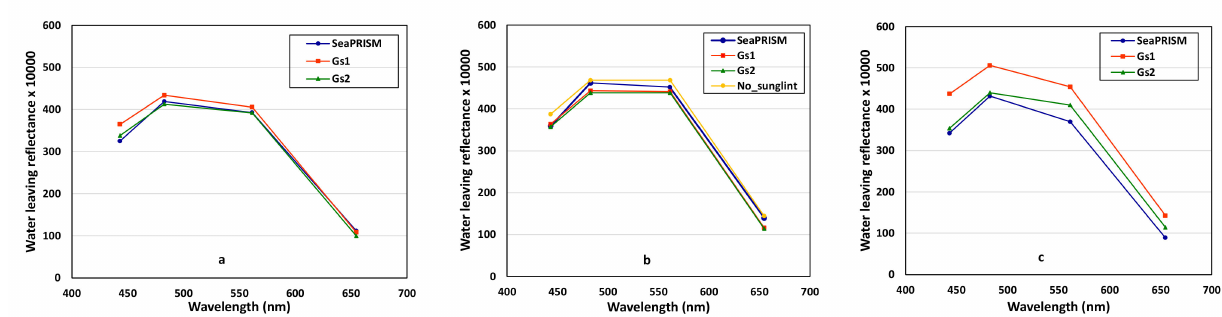
Figure 7. Water-leaving reflectance comparison between SeaPRISM observations and satellite observations. ( a ) Average 14 days; ( b ) average six low sun glint cases; and ( c ) average three high sun glint